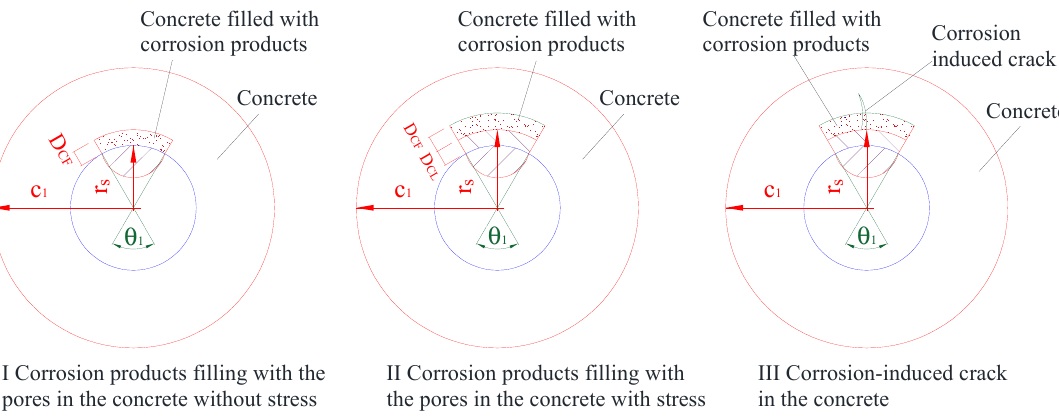
Figure 3. Three stages of the corrosion-induced cracks.